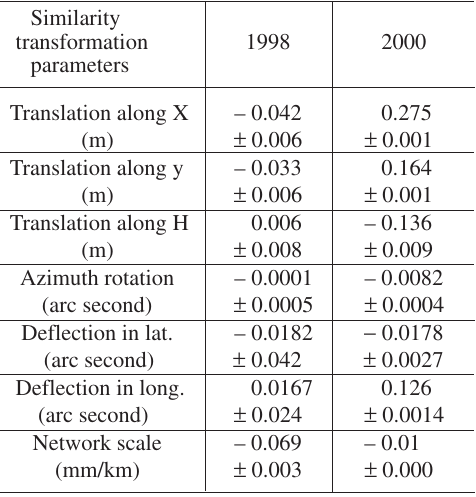
Table IV. Transformation parameters for 1998 and 2000 network